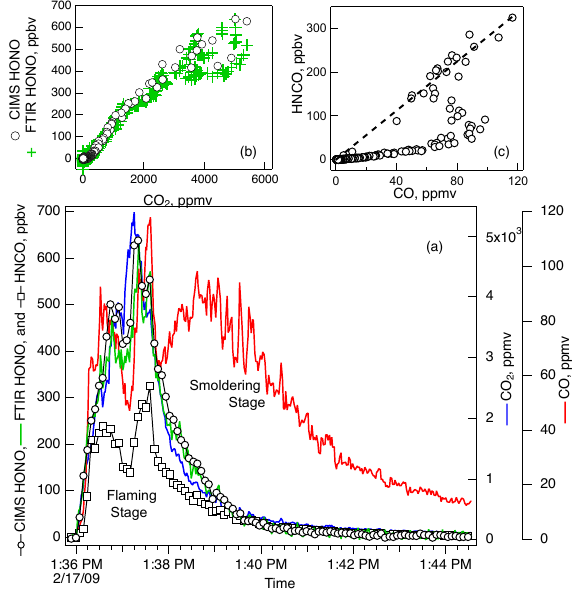
Fig. 8. A timeline (a) for the emission of: HONO measured by CIMS (open circles) and by FTIR (green line), HNCO (open squares), CO 2 (blue line) and CO (red) during a biomass burning experiment. Also shown is (b) the correlation of both HONO mea- surements with CO 2 and (c) the correlation of HNCO with CO, showing the correlation with flaming-stage CO of 0.28% (dashed